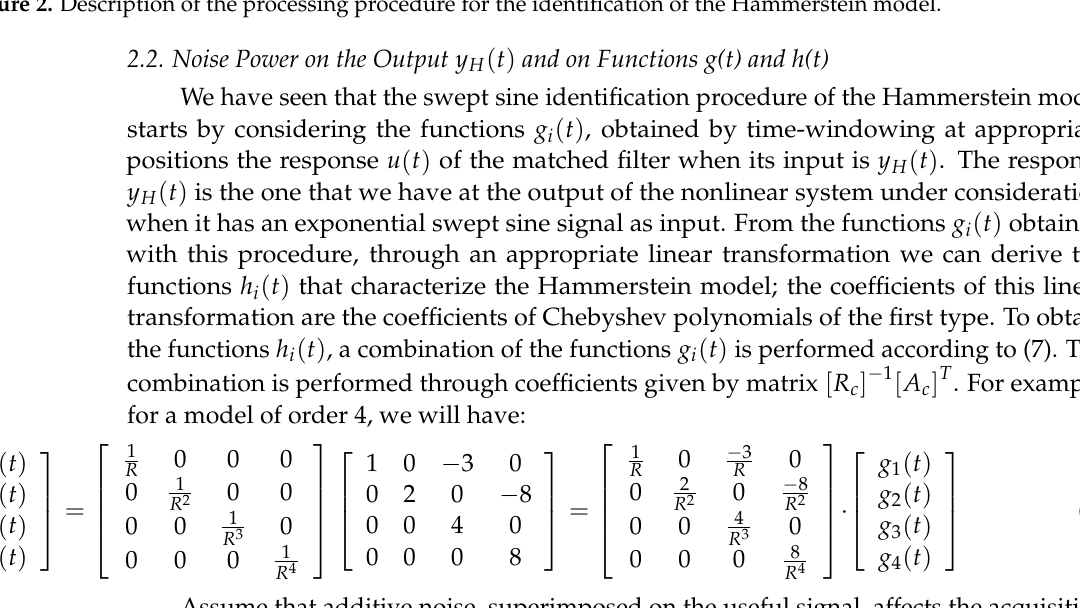
Figure 2. Description of the processing procedure for the identification of the Hammerstein